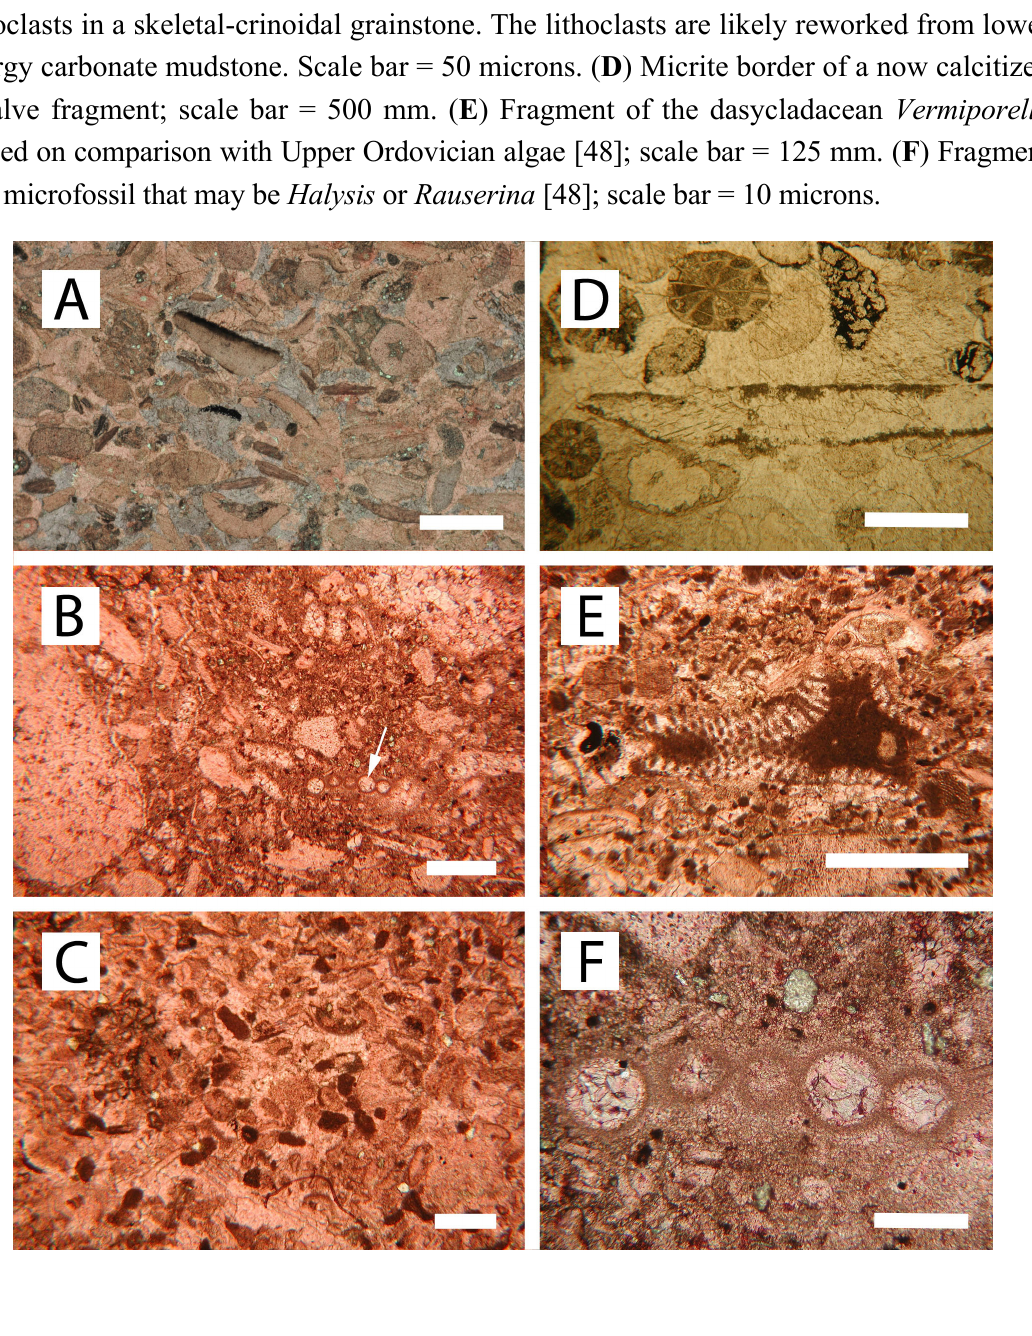
Figure 9. Petrographic characteristics of the Nepean Point Member. ( A ) Crinoid-rich microfacies with abundant intergranular iron-poor (pink) syntaxial calcite on echinoderm fragments. Scale bar = 50 microns. ( B ) Skeletal packstone with fragment possibly of Halysis sp. (arrow), shown in detail in ( F ); scale bar = 50 microns. ( C ) Abundant micritic lithoclasts in a skeletal-crinoidal grainstone. The lithoclasts are likely reworked from lower energy carbonate mudstone. Scale bar = 50 microns. ( D ) Micrite border of a now